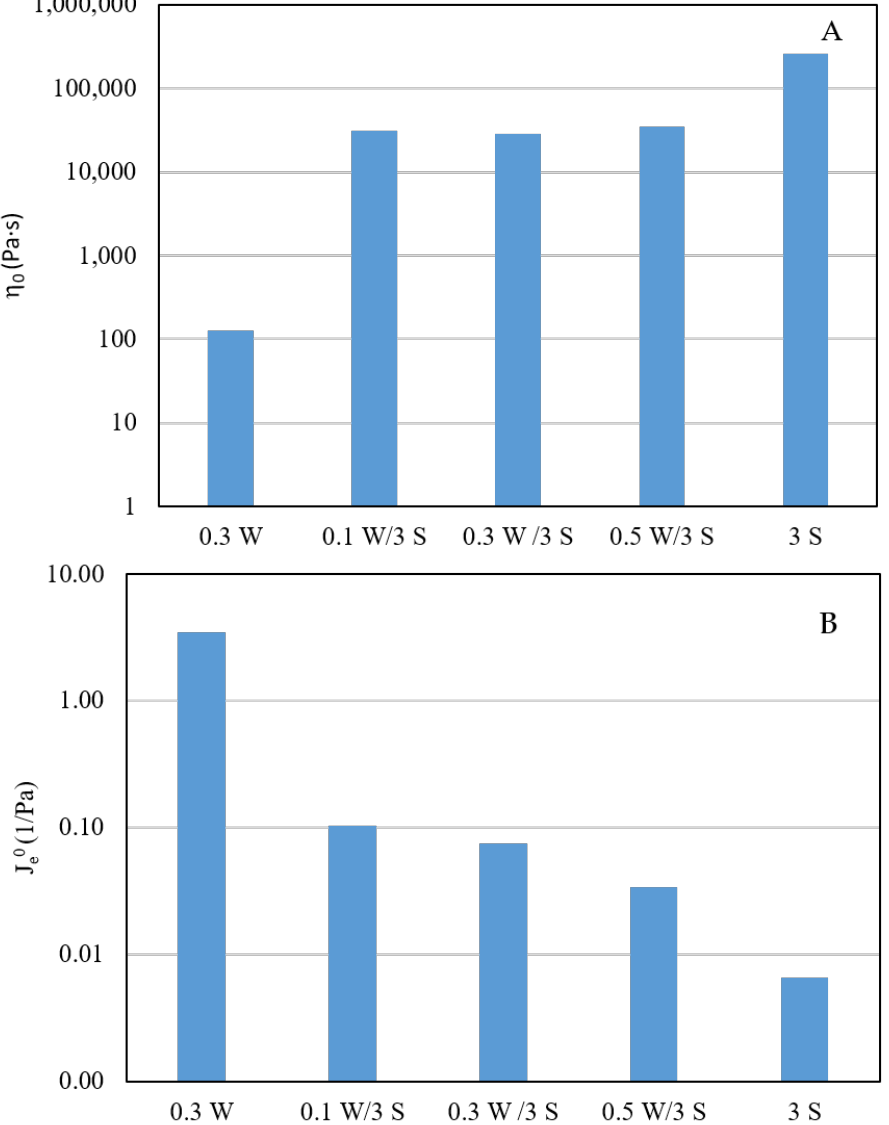
Figure 4. ( A ) Zero-shear viscosity ( η 0 ) and ( B ) equilibrium compliance (J e0 ) values obtained for all the systems studied.